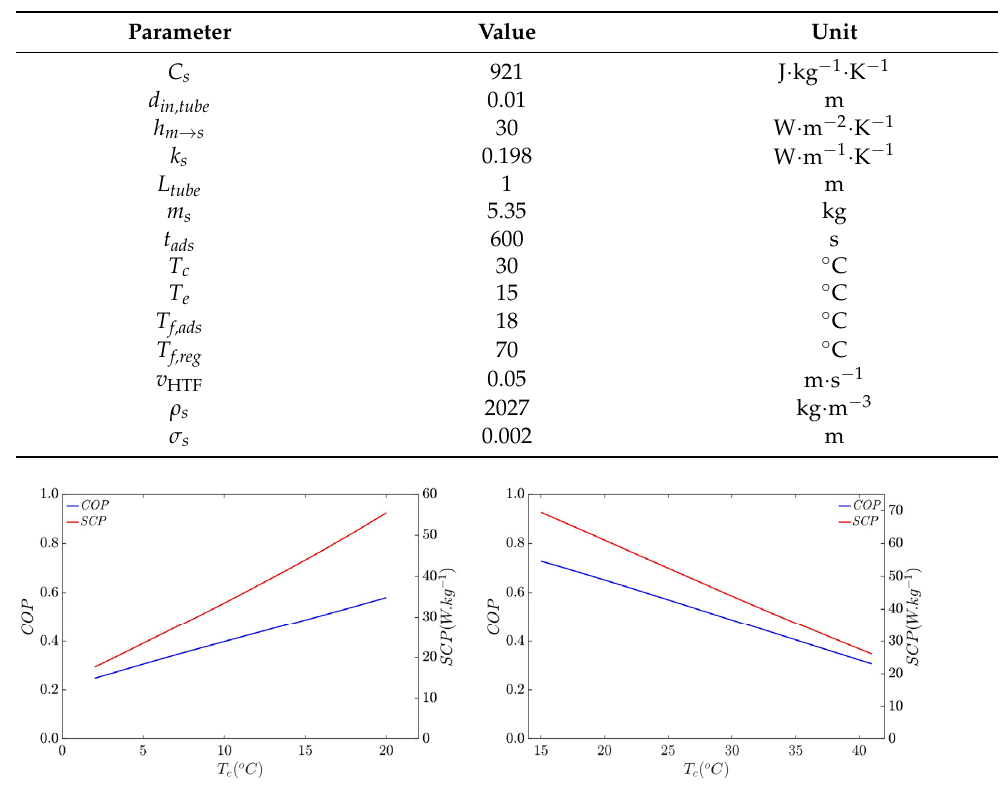
Figure 4. COP and SCP variation with the evaporator (on the left ) and condenser (on the right ) temperatures.